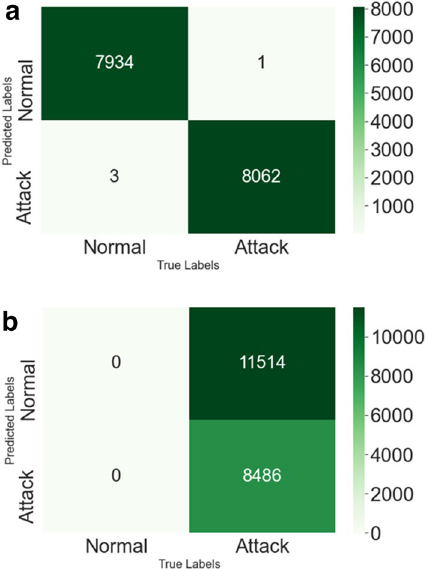
Figure 10. Confusion matrices for known and unknown Threats.